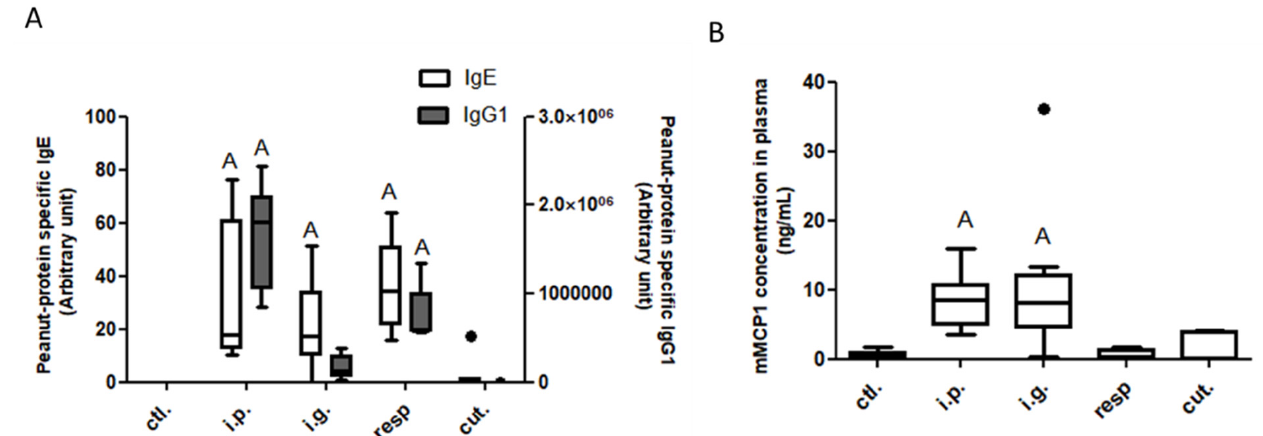
Figure 2. Assessment of food allergy induction after exposure through different routes: Peanut-specific IgE (open bars) and IgG1 (gray bars) ( A ) and mMCP1 ( B ) concentrations in plasma collected 1 h after an oral food challenge from mice previously exposed through the intraperitoneal (i.p.), intragastric (i.g.), respiratory (resp.), or cutaneous (cut.) routes, and in non-exposed mice (ctl.; control mice). “A”: indicates a significant difference between indicated group and control group ( p < 0.05 using non-parametric Kruskal–Wallis and Dunn’s post-test). Bold black dots represent outliers.